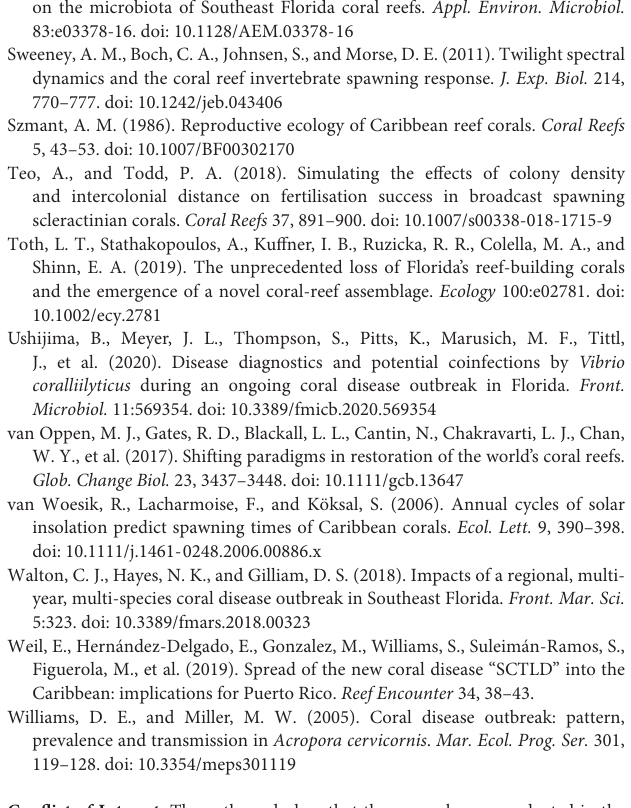
Figuerola, M., et al. (2019). Spread of the new coral disease “SCTLD” into the Caribbean: implications for Puerto Rico. Reef Encounter 34,